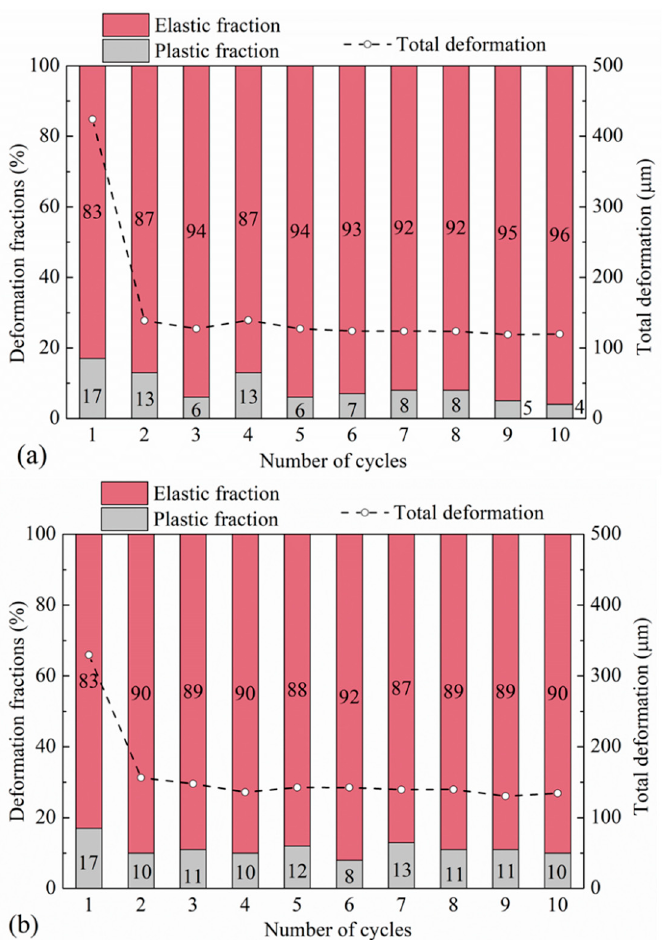
Figure 14. Displacement magnitude and different fractions in preloading tests for ( a ) LBS–rubber and ( b ) CDG–rubber